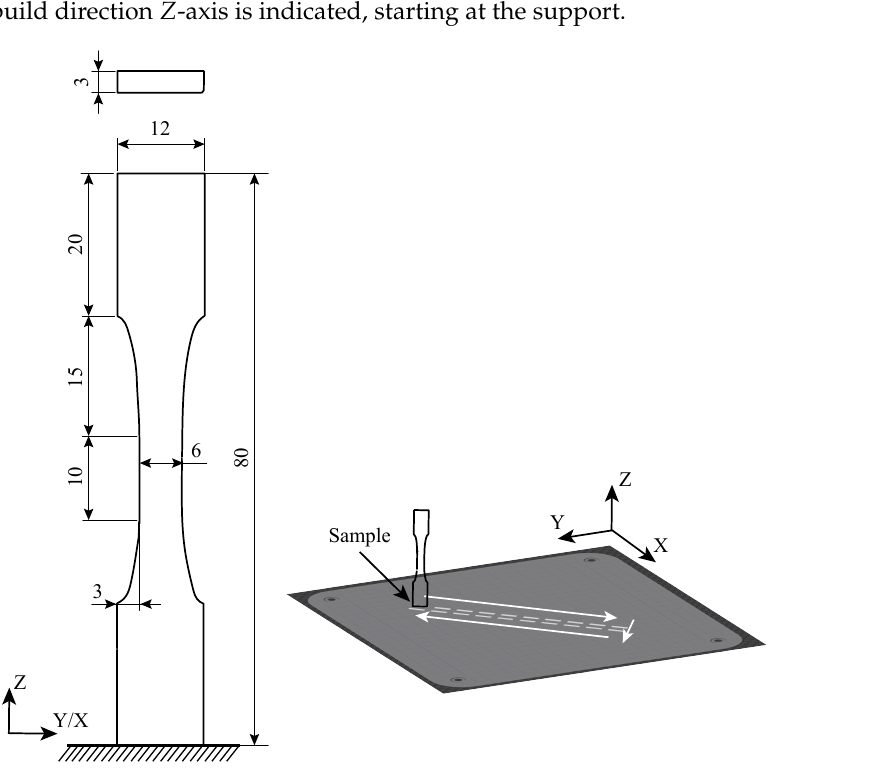
Figure 1. Dimensions (in mm.) of the Ti-6Al-4V specimens with build direction in Z and the support.